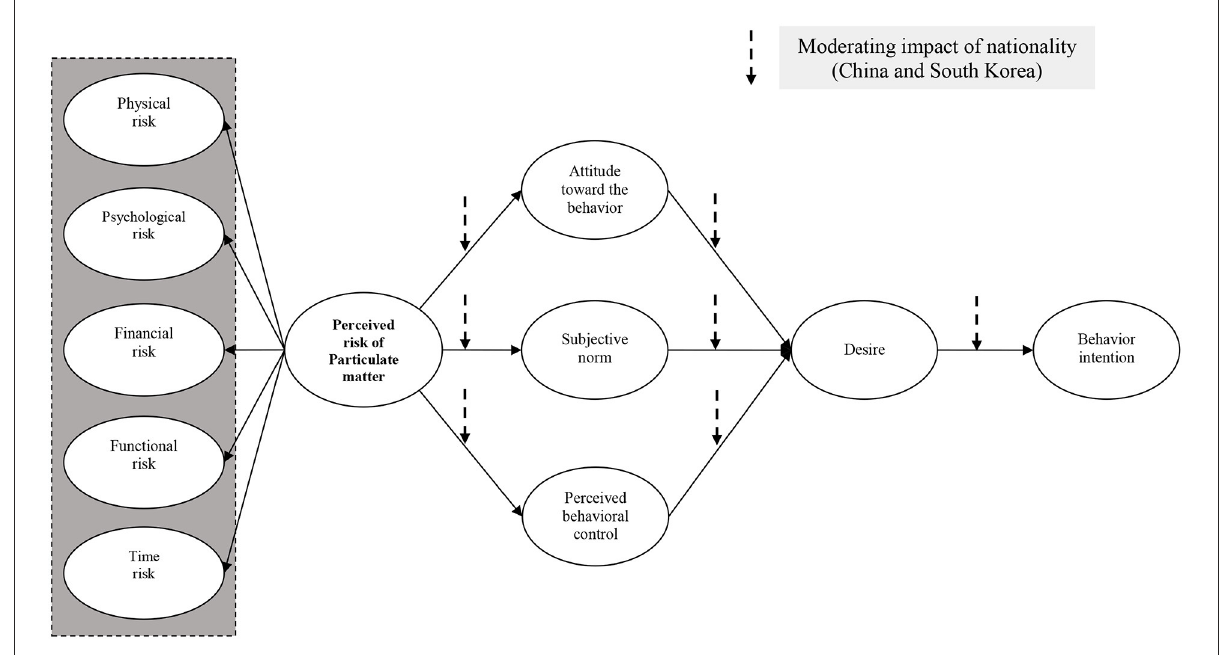
FIGURE1 Proposed conceptual